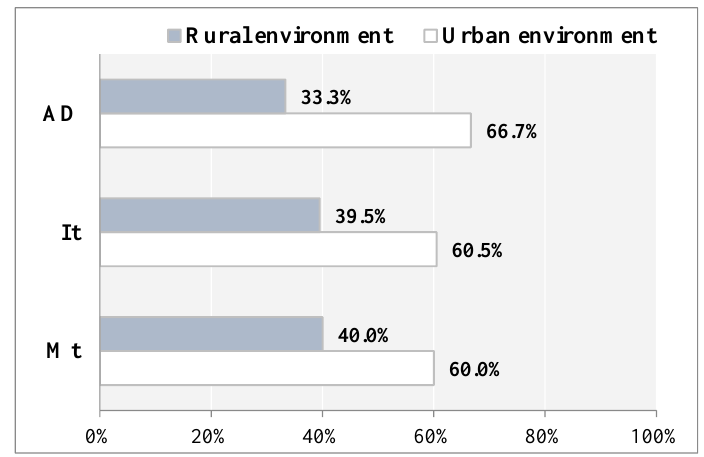
Figure 5. Accident analysis: percentage values of some accident indicators.